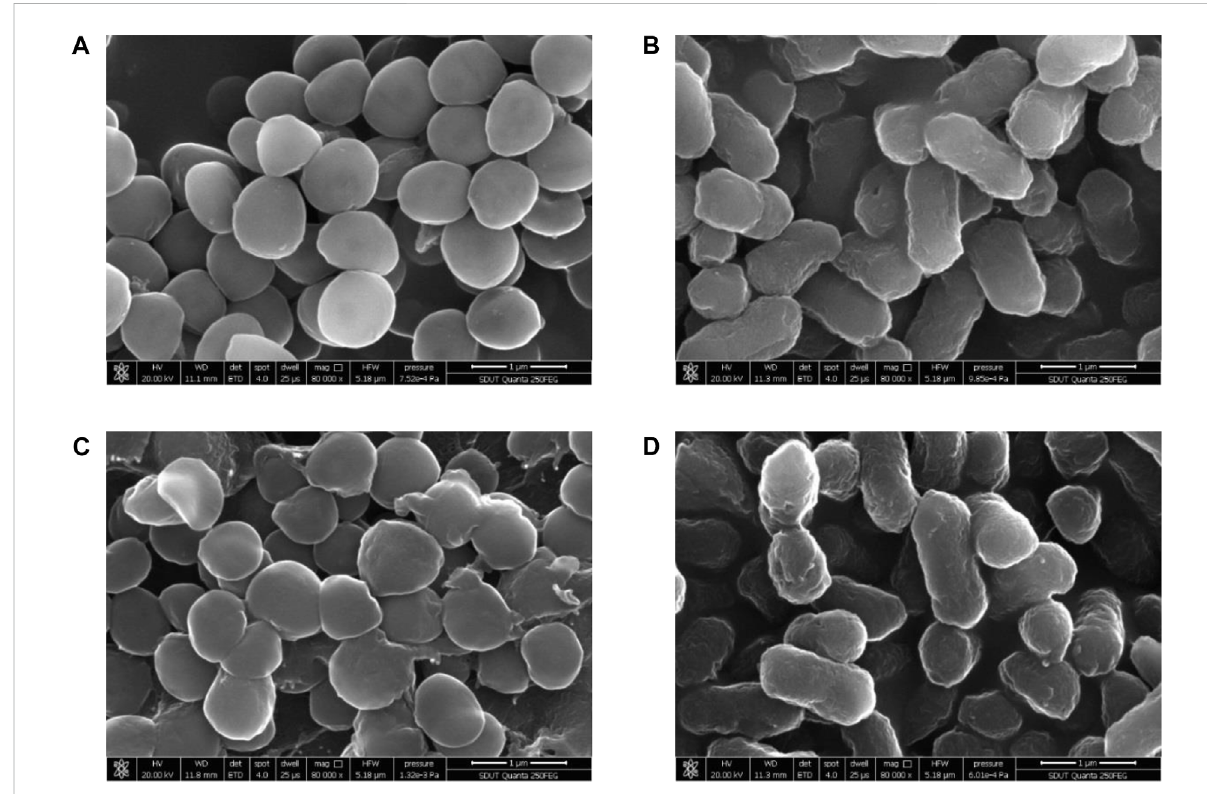
SEM images of S. aureus CMCC 26003 and E . coli CMCC 44102 in the absence of sanjuanolide (A,B) and presence of sanjuanolide (C,D)